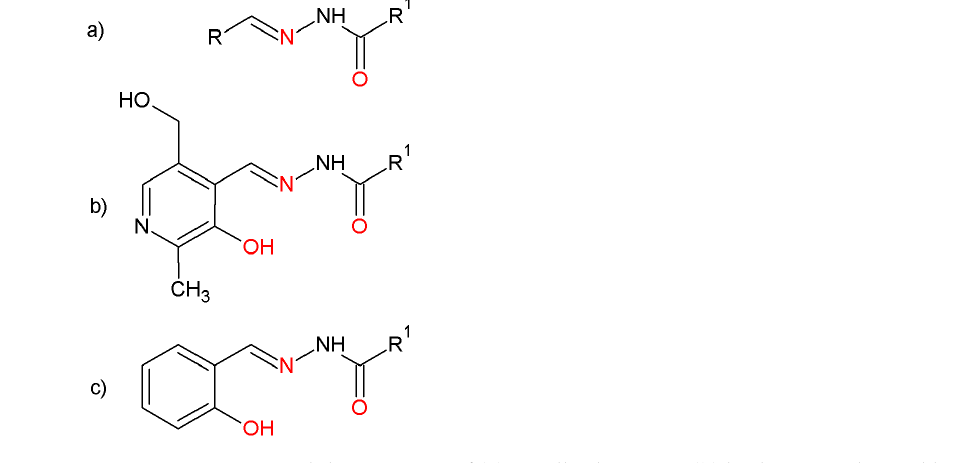
Figure 1. Structure and donor atoms of ( a ) aroylhydrazones, ( b ) hydrazones derived by pyridoxal, and ( c ) hydrazones derived by salicylaldehyde.